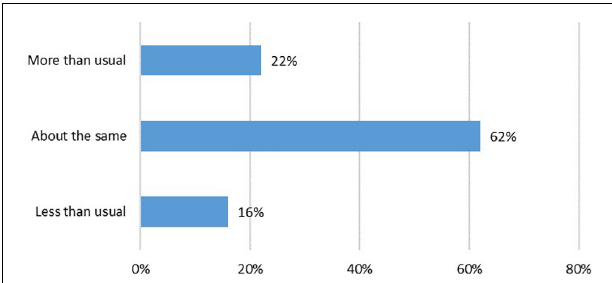
FIGURE 1 | Frequency of arts engagement in April/May during lockdown vs.